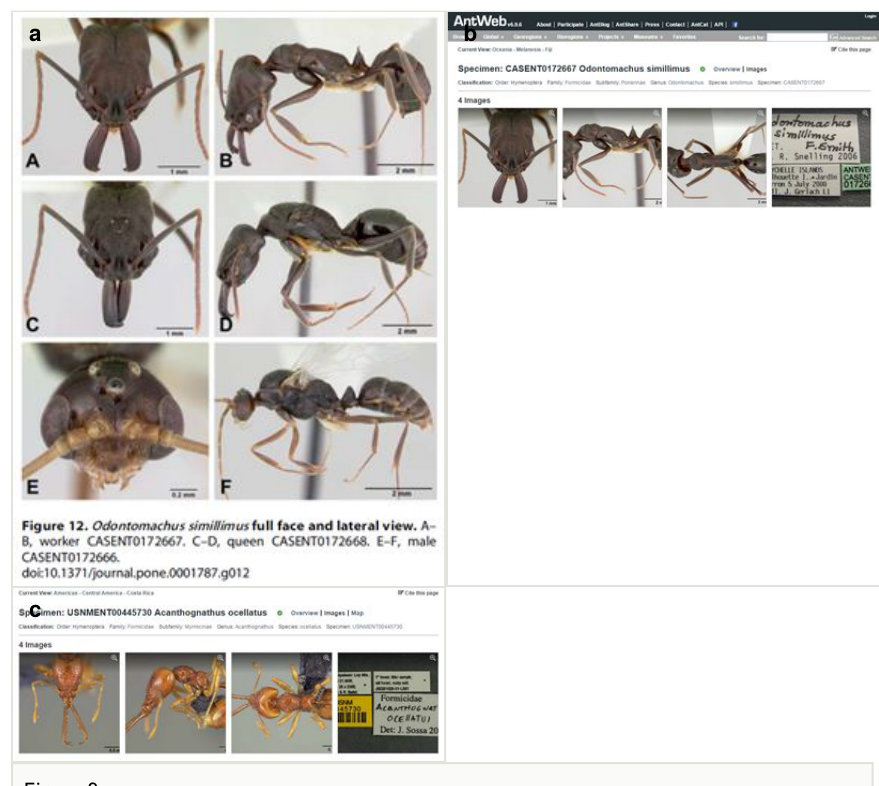
Figure 9. Extended focus composite photographs of ants in a taxonomic publication and the